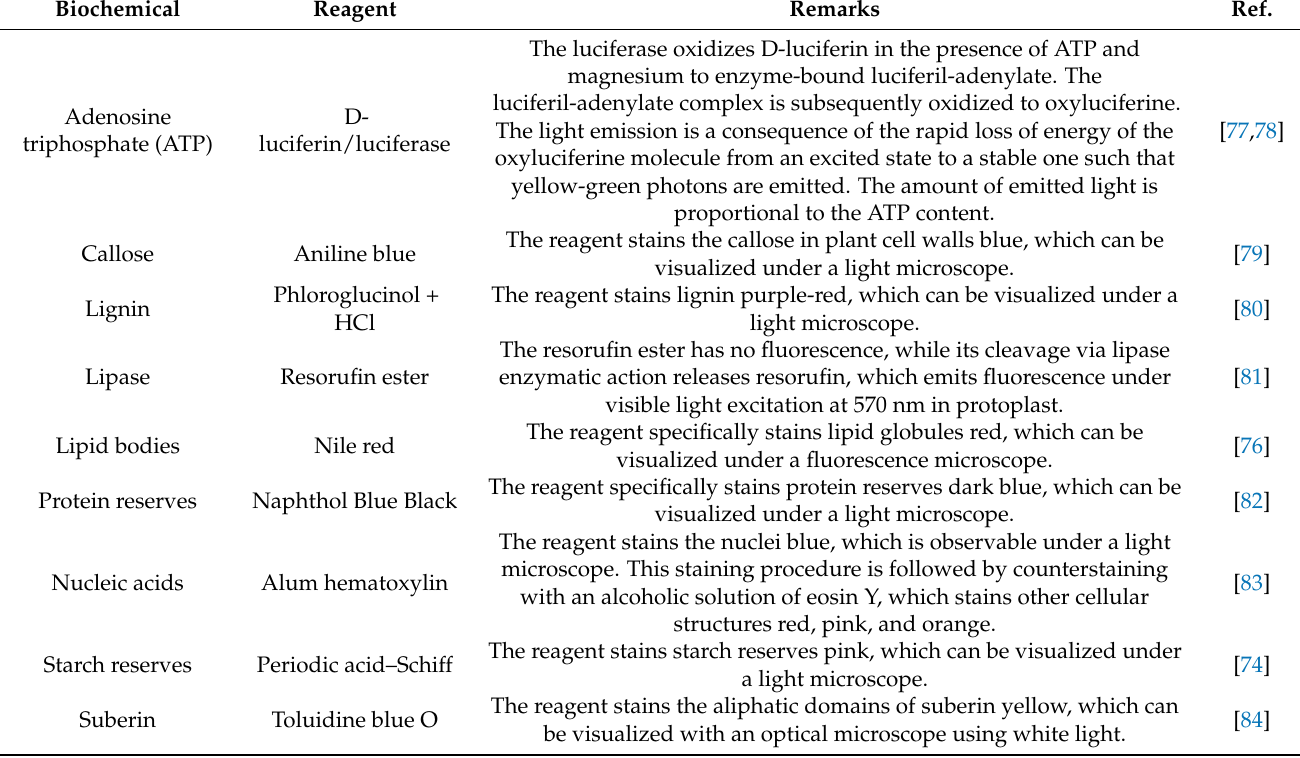
Table 2. Histological observation of living cells under different environmental conditions.